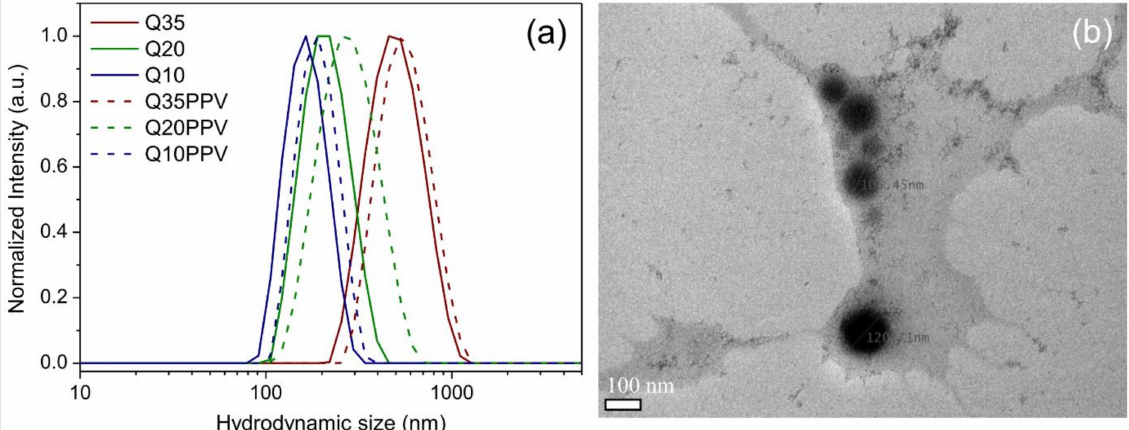
Figure 2. Hydrodynamic size distribution profile obtained by DLS of bare chitosan nanoparticles with varying DA (Q35, Q20 and Q10) and of the correspondent CN-PPV loaded particles (labelled as PPV) ( a ); representative TEM image from Q20 used as example at 100 nm of magnification, showing an average size and shape after drying ( b